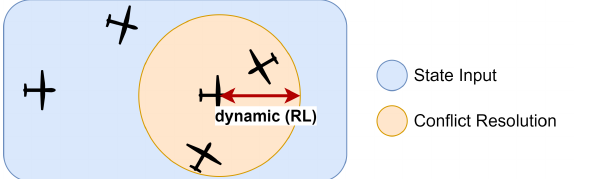
Figure 2. The RL method receives information on the aircraft surrounding the ownship through the state input, and outputs a look-ahead value to be used for conflict